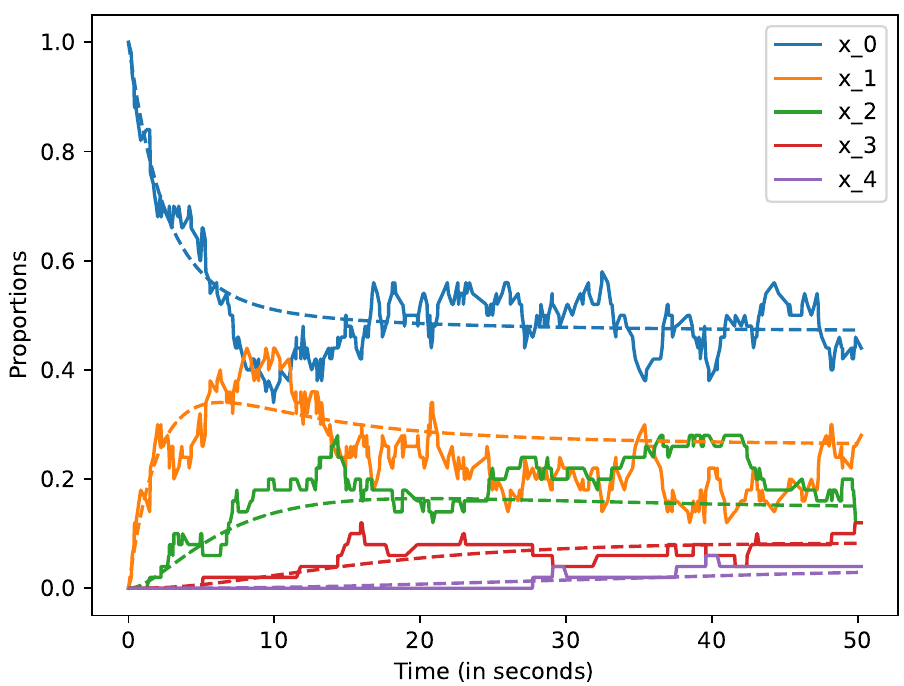
Figure 4. Mean-field approximation for N = 50 devices. Time in seconds.